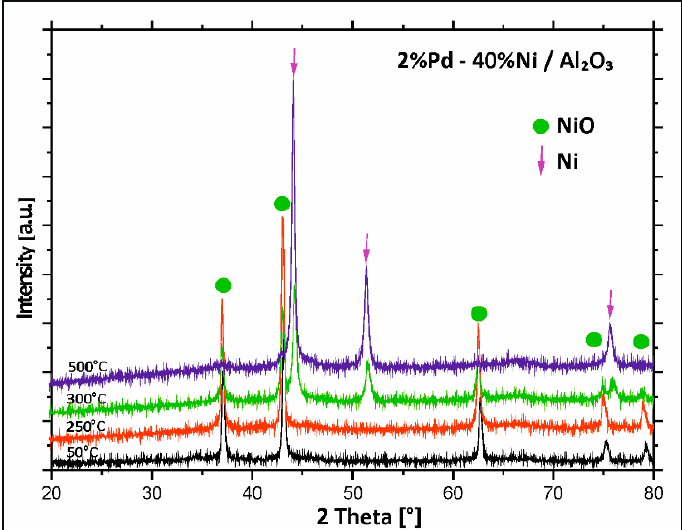
Figure 5. X-ray powder patterns recorded during reduction of calcined bimetallic Pd–Ni/Al 2 O 3